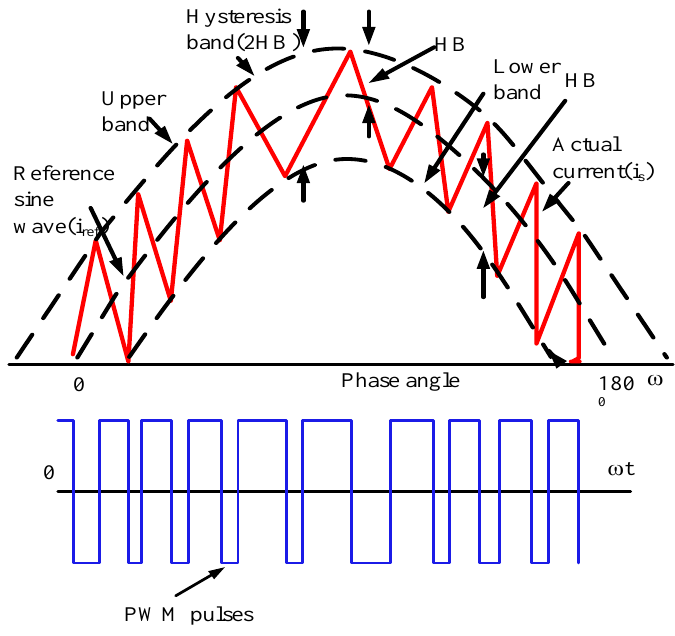
Figure 5. Graphical representation of fixed band hysteresis current controller (HCC).